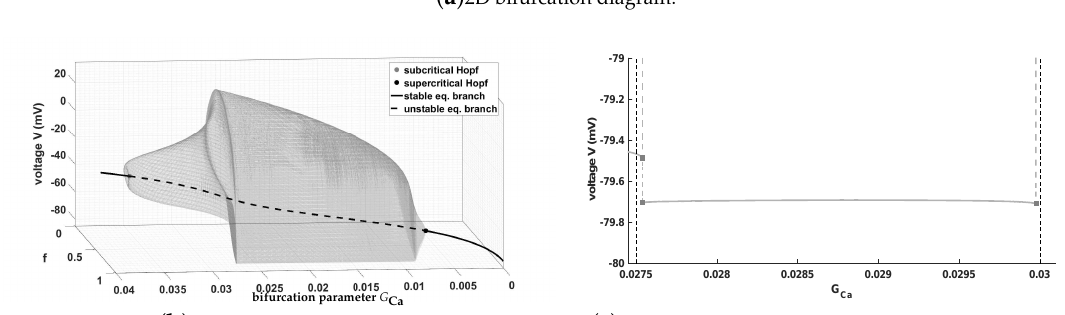
( a ) 2D bifurcation diagram.